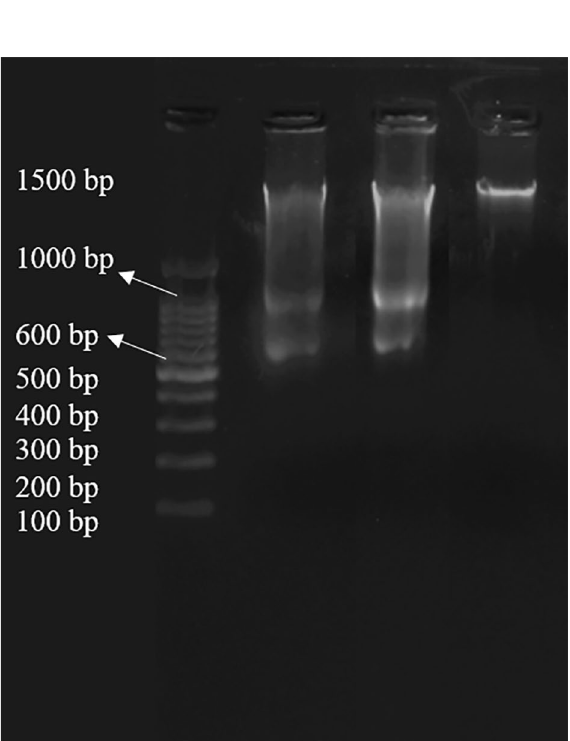
Figure 7. DNA ladder results of Sf9 cells induced by compound 10 . Lanes: 1: 2000 bp marker; 2: positive control (Azadirachtin A); 3: compound 10 ; 4: negative